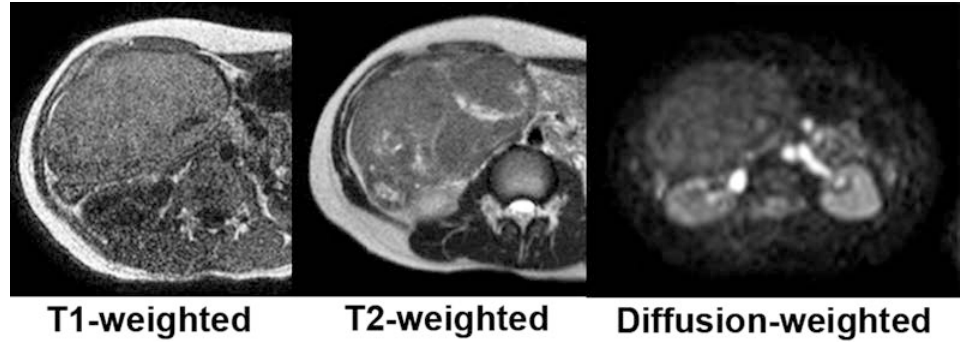
Figure 2 MRI The tumor was solid in the right upper abdomen, it was separated from the uterus and ovaries, and no obvious abnormalities were found in the pelvis. A T1-weighted image shows a light high signal. A T2-weighted image shows an iso-signal with a non-uniform high signal internally. A